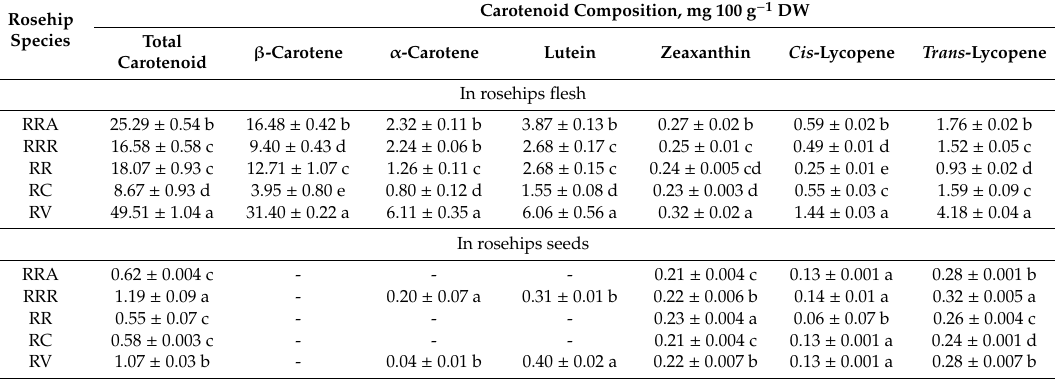
Table 1. Carotenoid composition and content (mg 100 g − 1 dry weight (DW)) of di ff erent organic rosehip species flesh and